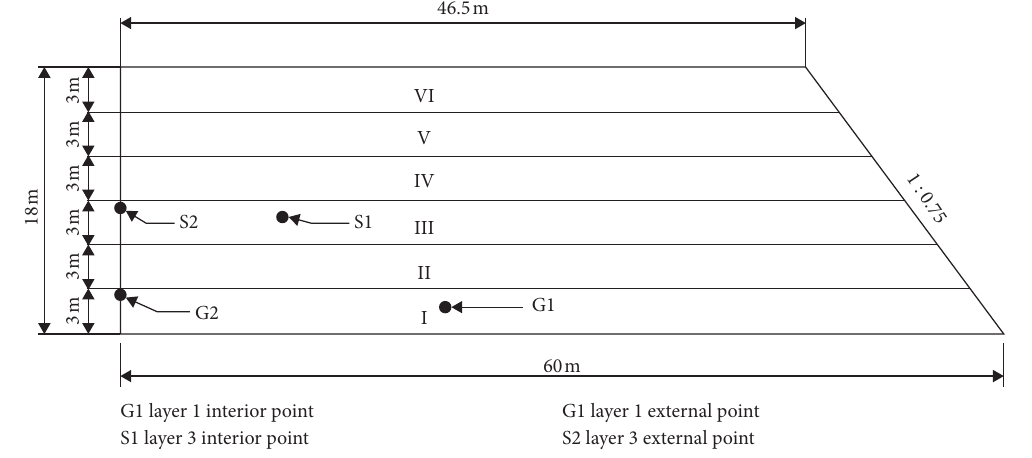
Figure 16: Part of a gravity dam size and key point diagram.